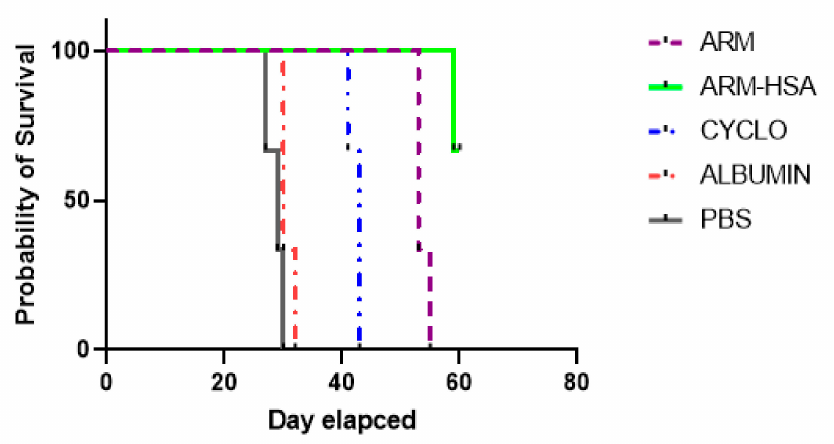
Figure 10. Survival chart of tumor mice receiving artemether, nanoparticle, albumin, cyclophos- phamide and PBS during 60 days after treatment. Alive mice up to day 60 were found only in the nanoparticle-receiving group. Mice in other groups died before day